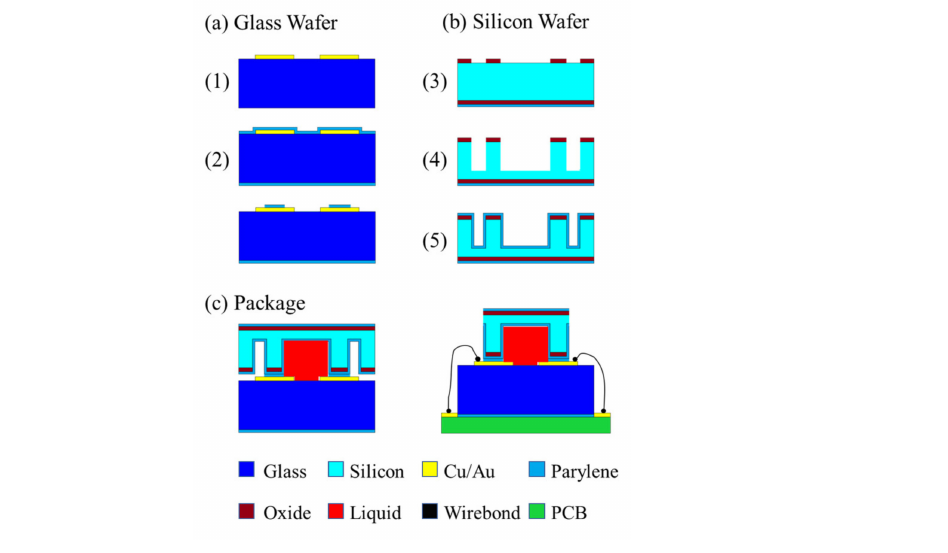
Figure 14. Manufacturing and packaging process for a fluid